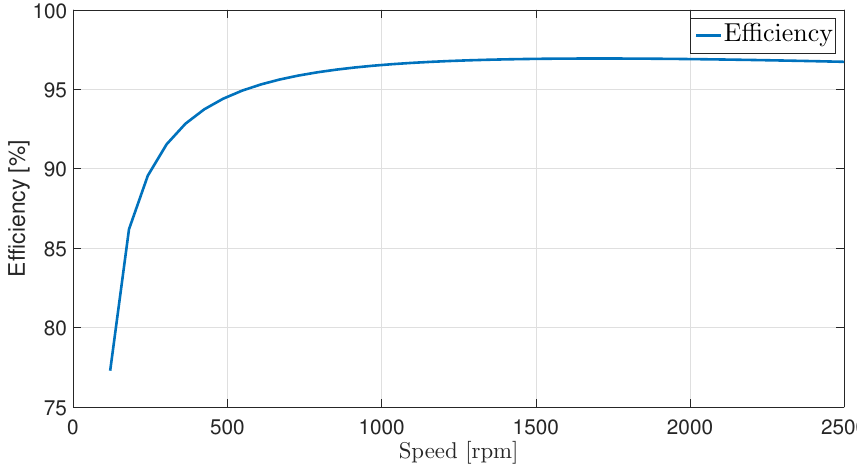
Figure 14. The efficiency variation with the speed.